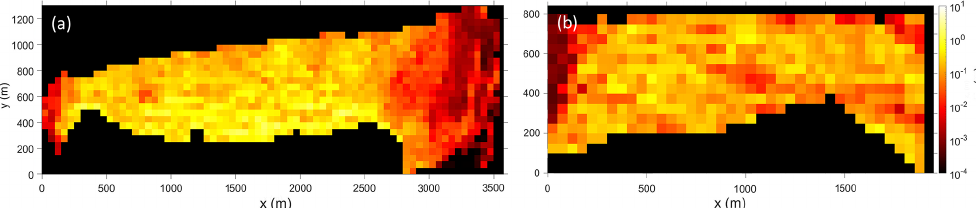
Figure 7. Variability in z 0 values for the glaciers Tunabreen (a) and Heuglinbreen (b) calculated with the Smith model for a down-glacier wind direction and a sub-grid size of